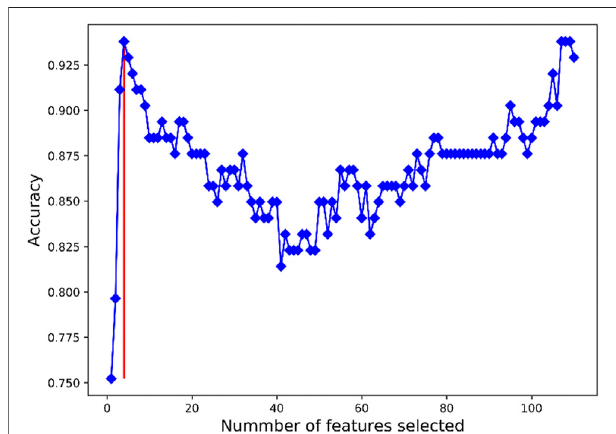
FIGURE 3 | Results of SVM-RFE feature gene selection. X -axis refers to the number of feature genes in RFE analysis. Y -axis refers to the accuracy of the model. Blue broken line refers to the tendency of accuracy with the numberoffeaturegenes.Redverticallinereferstothenumberofoptimal feature genes as the accuracy was the